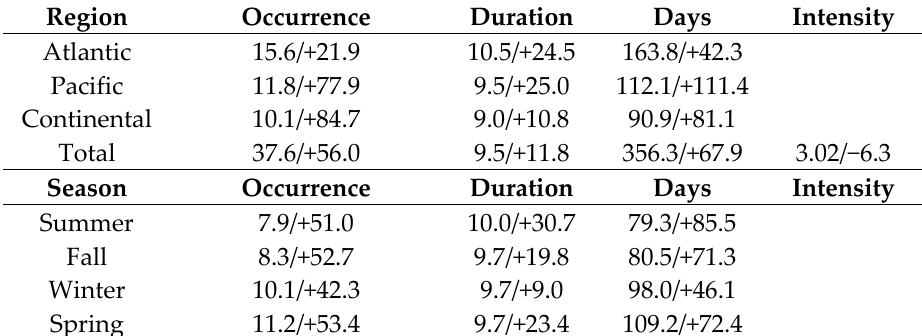
Table 2. Character of Northern Hemisphere blocking events per year as a function of region and season for all characteristics since the study of [1]. The change in the value is expressed as a